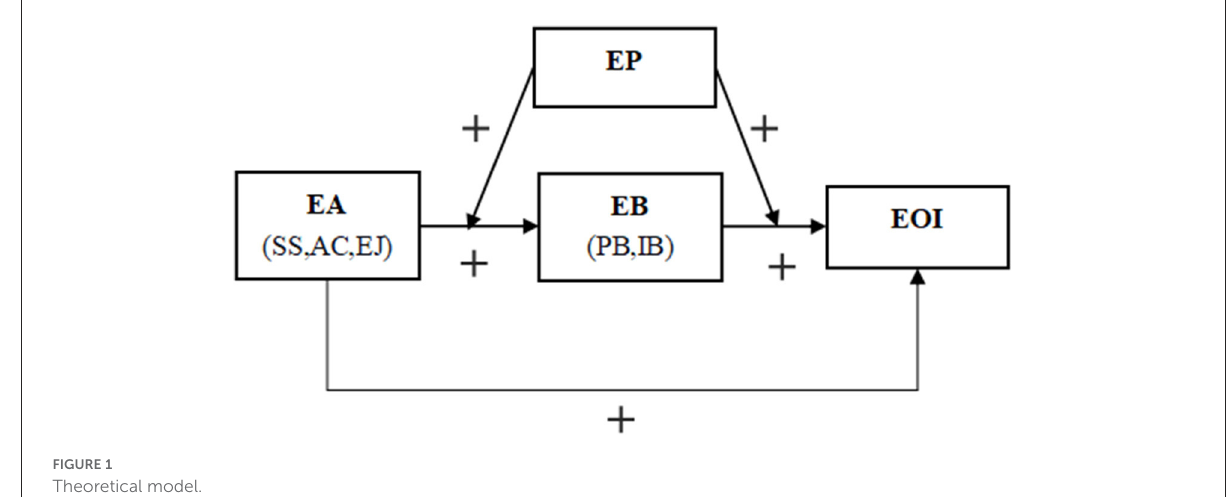
FIGURE1 Theoretical model.